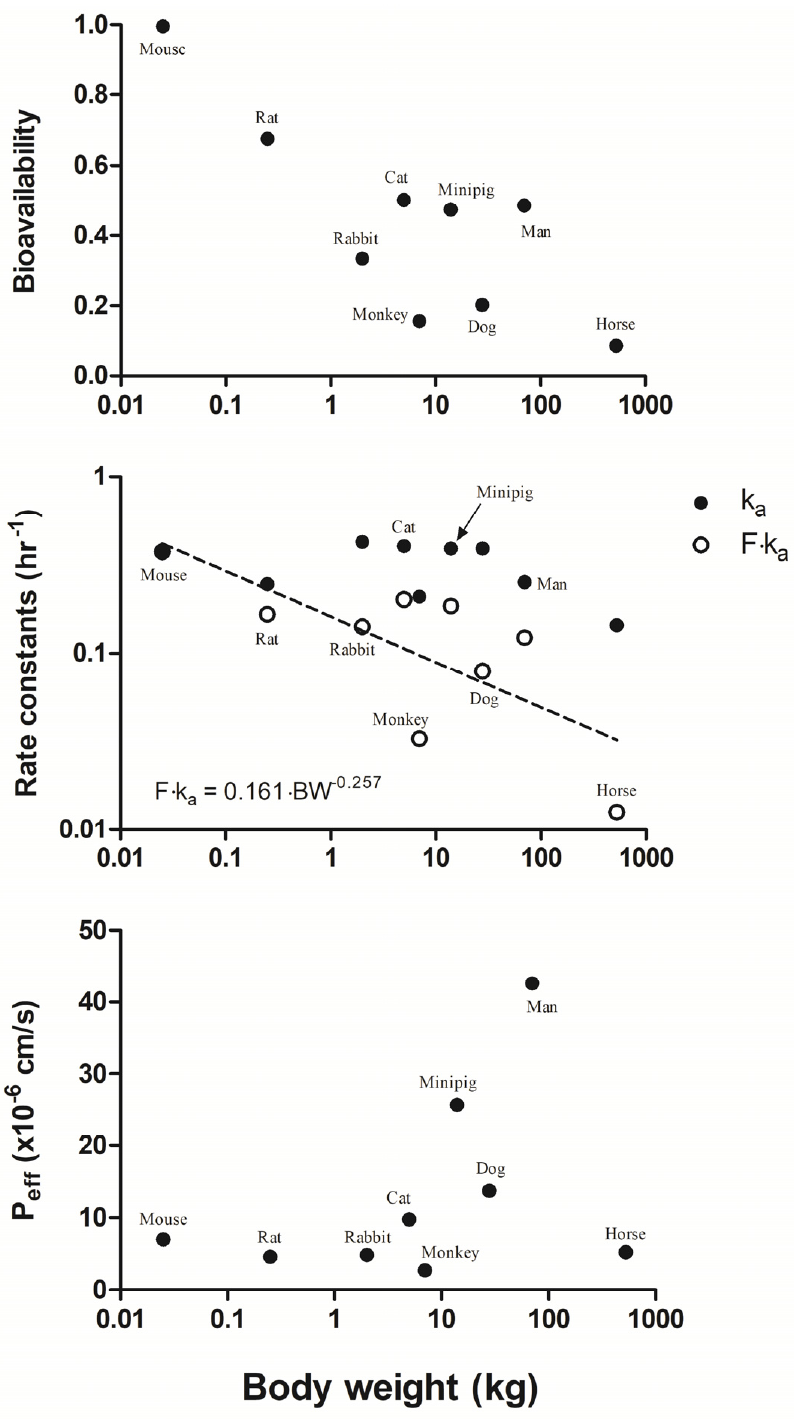
Figure 5. Fitted pharmacokinetic parameters related to oral absorption of metformin in relation to body weights, including bioavailability ( F ), absorption rate constants ( k a and F · k a ), and intestinal effective permeability ( P ef f ). The fitted parameters for each species are listed in Table 5.